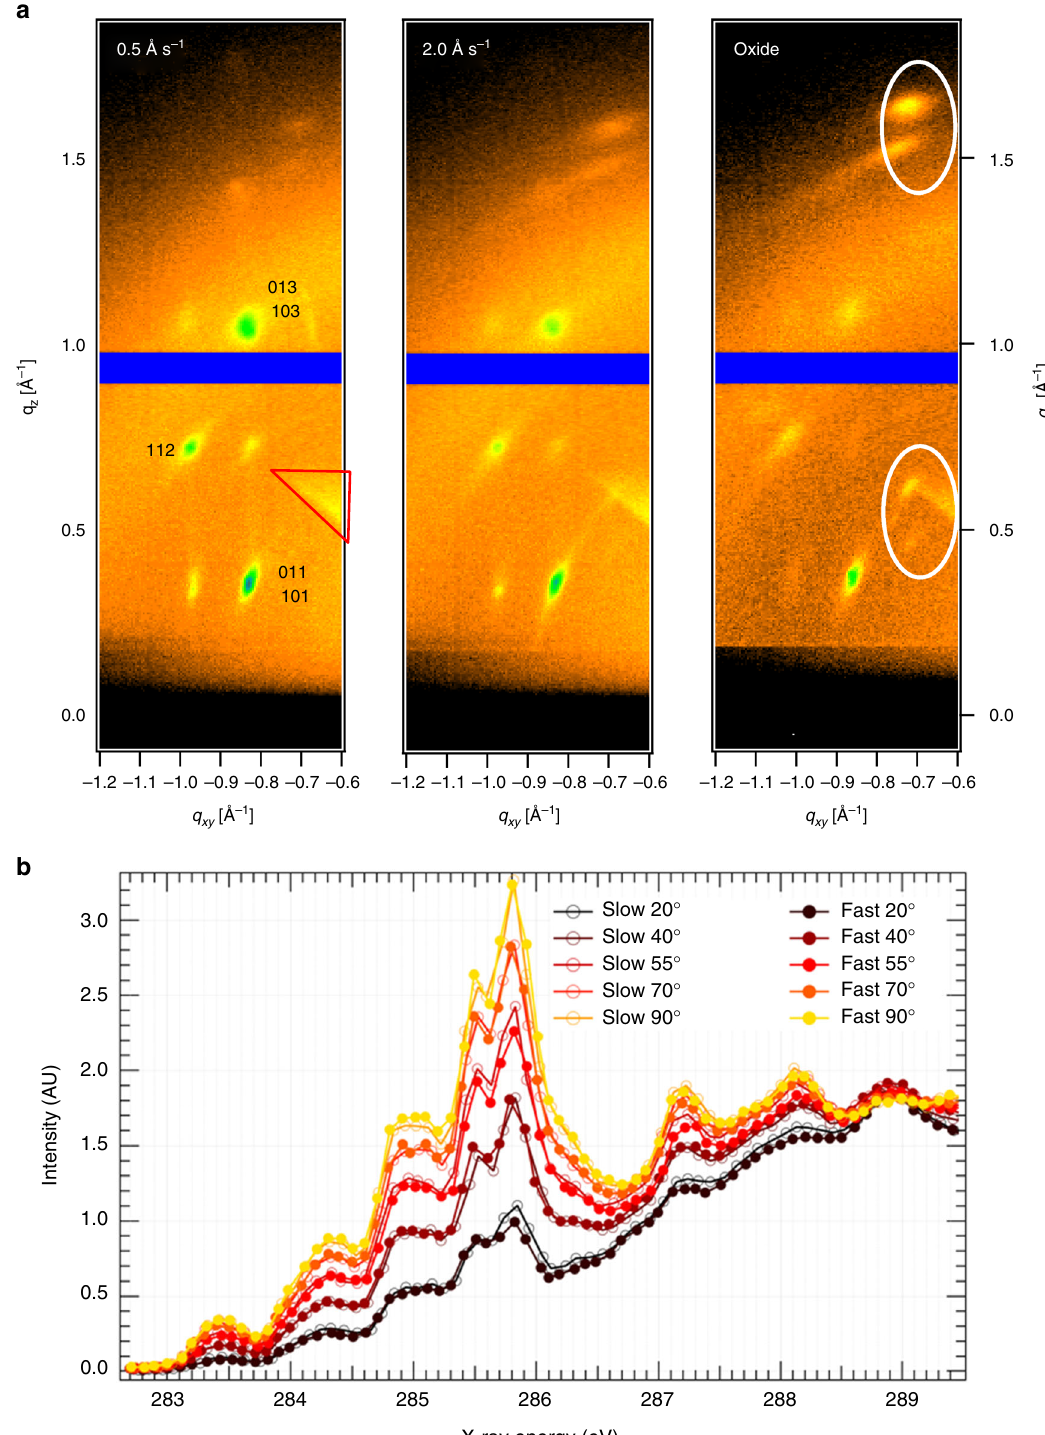
Fig. 3 μ GIWAXS and NEXAF Spectroscopy measurements. a μ GIWAXS was recorded on the contacts of patterned device substrates. Labeled features in the left panel arise from (001) oriented crystals. The triangular feature highlighted in red, present in all images, is a background artifact. Circled features in the right panel are features from the (111) oriented crystallites present on the oxide of long channels. b The NEXAFS intensity of the fast and slow fi lms at different angles between the surface normal and polarization vector of